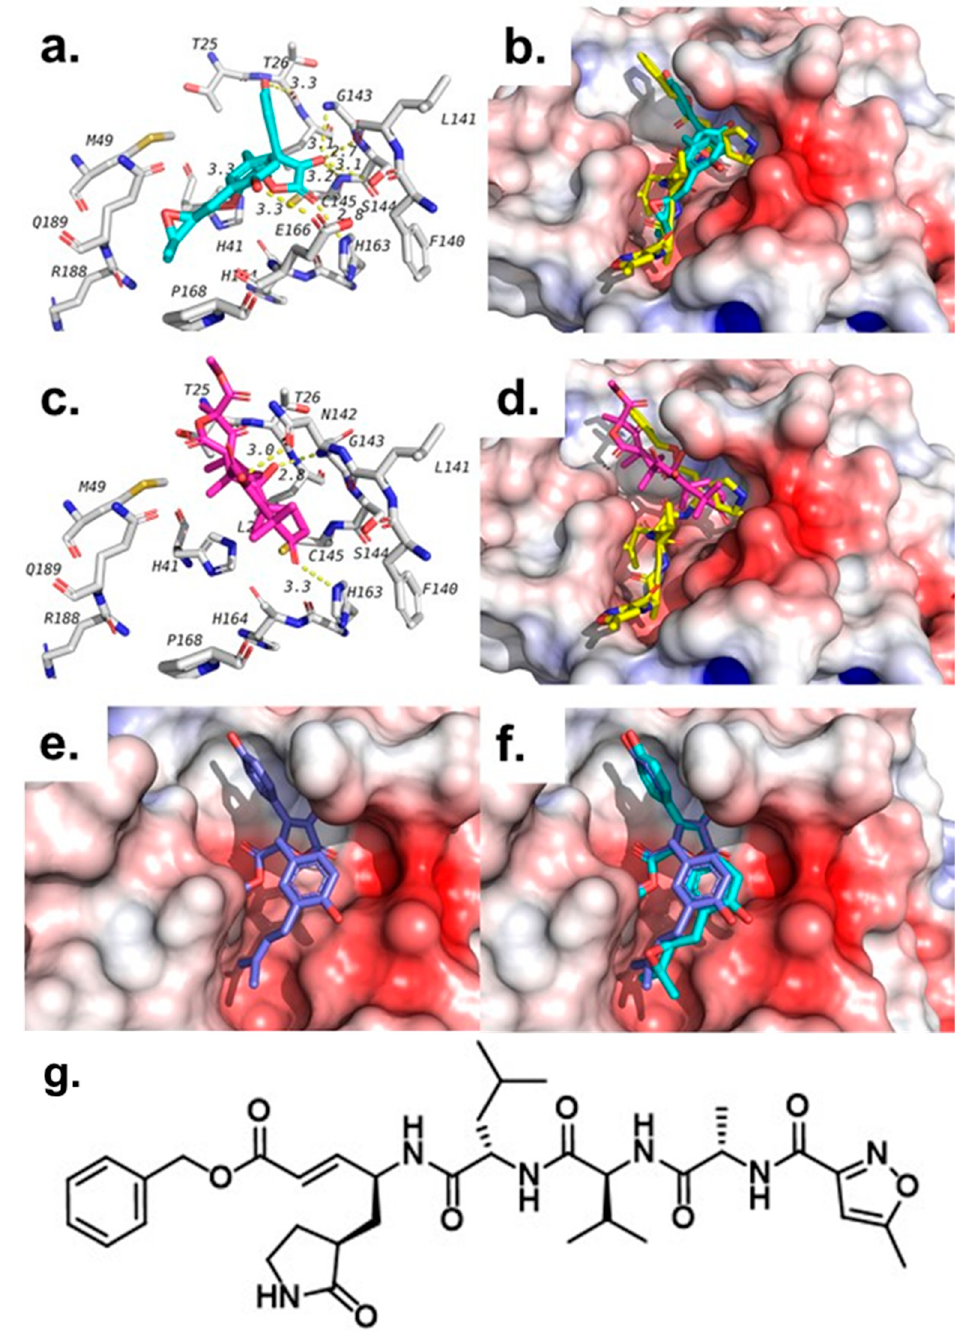
Figure 4. Poses and interactions of tested compounds in the active site of SARS-CoV-2 main protease (6LU7). ( a ) Interactions of butyrolactone III ( 2 ) (Cyan) in the active site. ( b ) Overlapping of butyro- lactone III ( 2 ) with co-crystalized ligand N3 (yellow). ( c ) Interactions of terretonin ( 3 ) (pink) in the active site. ( d ) Overlapping of terretonin ( 3 ) with co-crystallized ligand N3 (yellow). ( e ) Binding pose of butyrolactone I ( 1 ). ( f ) Overlapping of the binding poses of butyrolactone I ( 1 ) and butyrolactone III ( 2 ). ( g ) Structure of the co-crystallized ligand (N3) in 6LU7 pdb